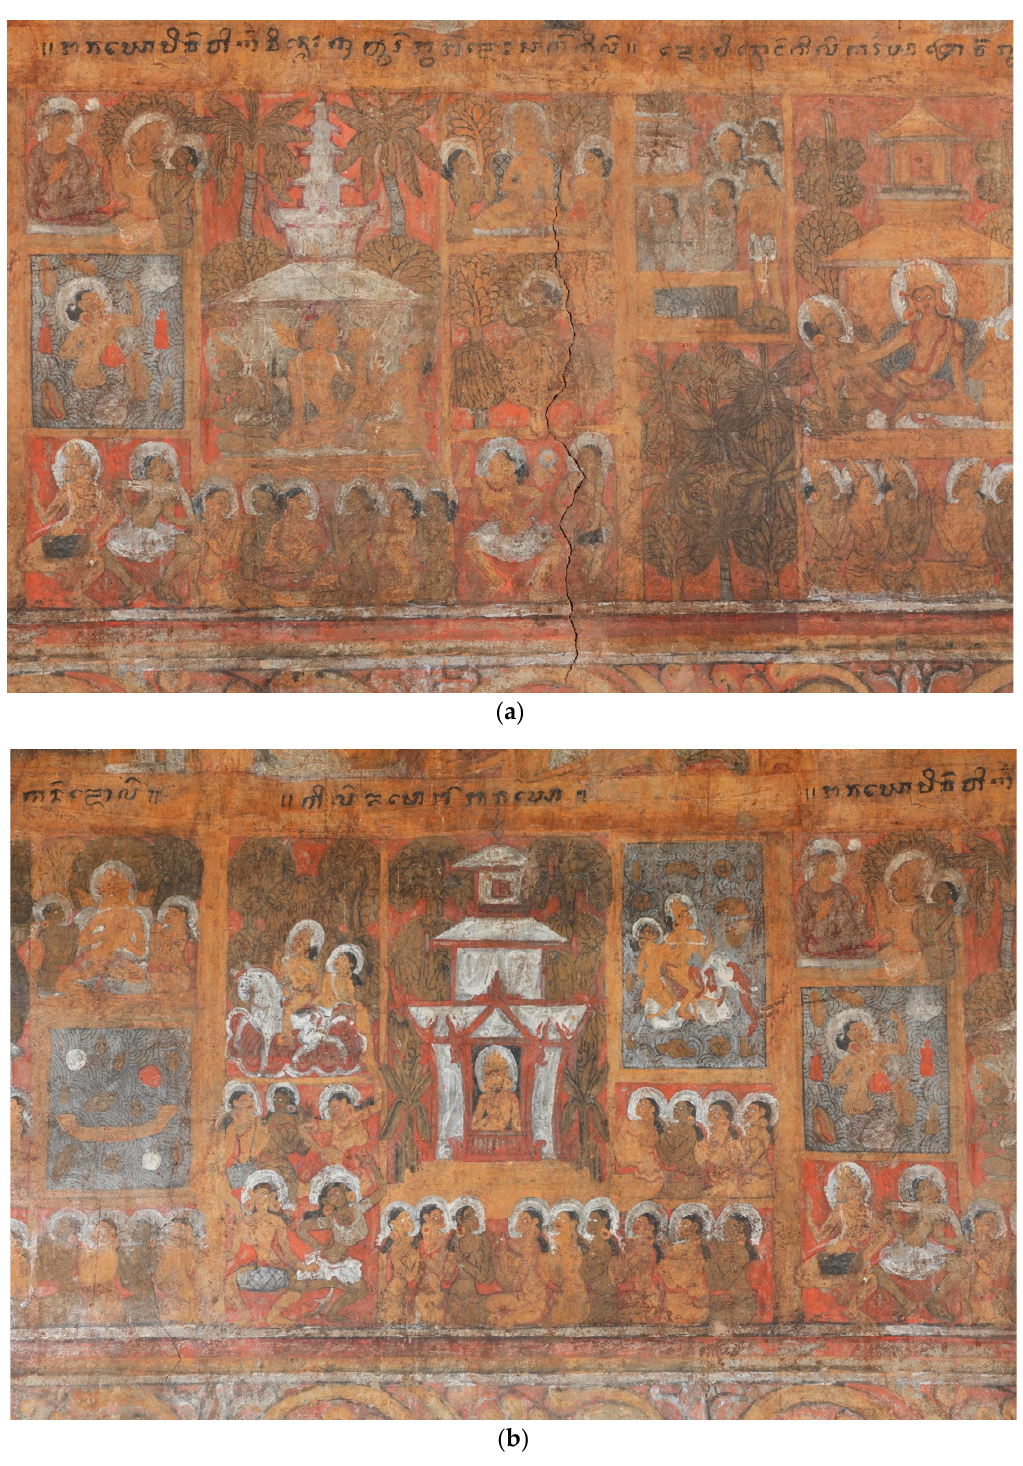
Figure 24. Pagan, Myinkaba Kubyaukgyi 1112 AD. Two Vimana stories, no inscriptions. Showing the luxurious lives of the inhabitants, surrounded by servants, orchestras, dancers, musicians, gardens and pools. ( a ) An uninscribed image of life in the heavens. ( b ) An uninscribed image of life in the heavens.